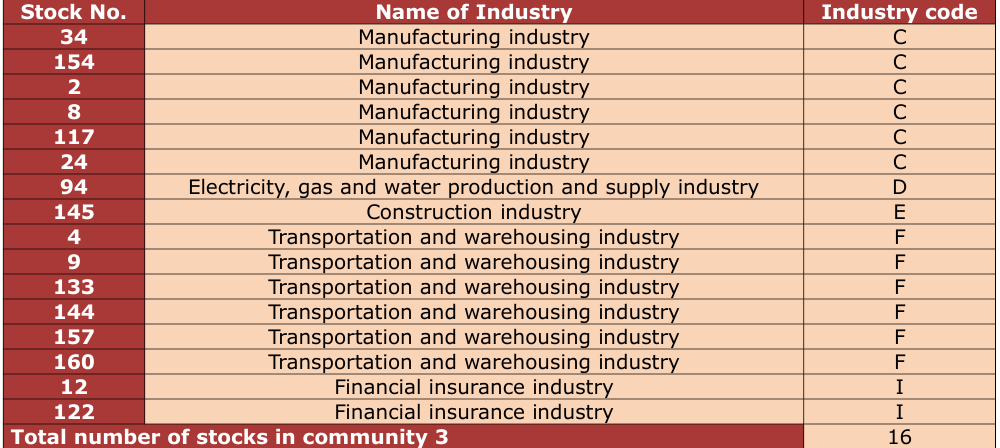
Table 6. Stocks in Community